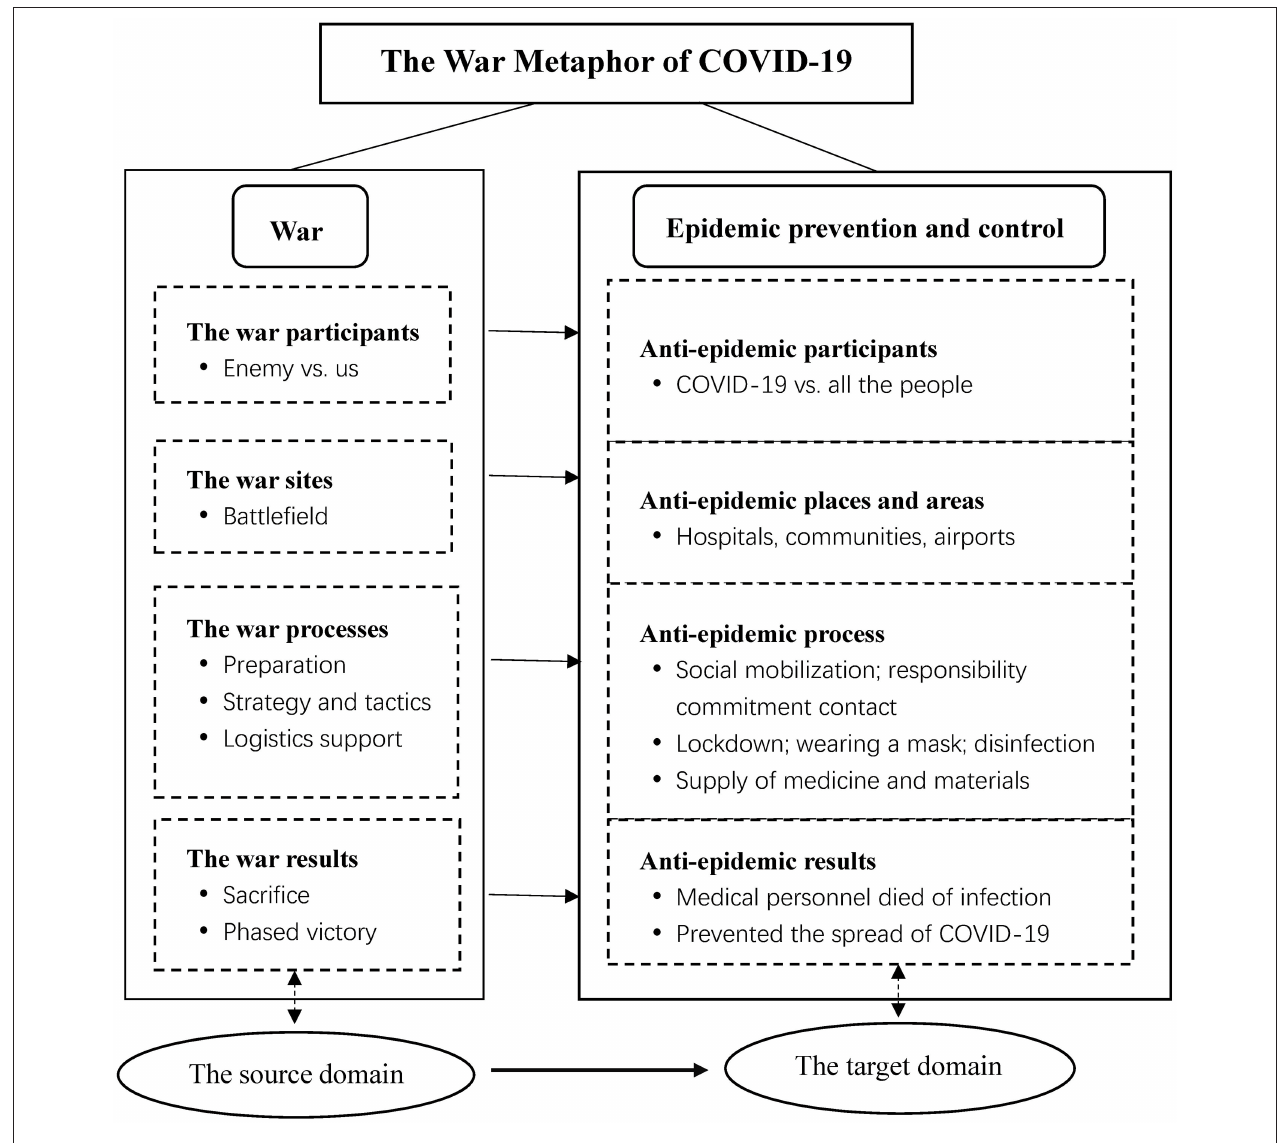
FIGURE 1 | The mapping relationship between the war metaphor and